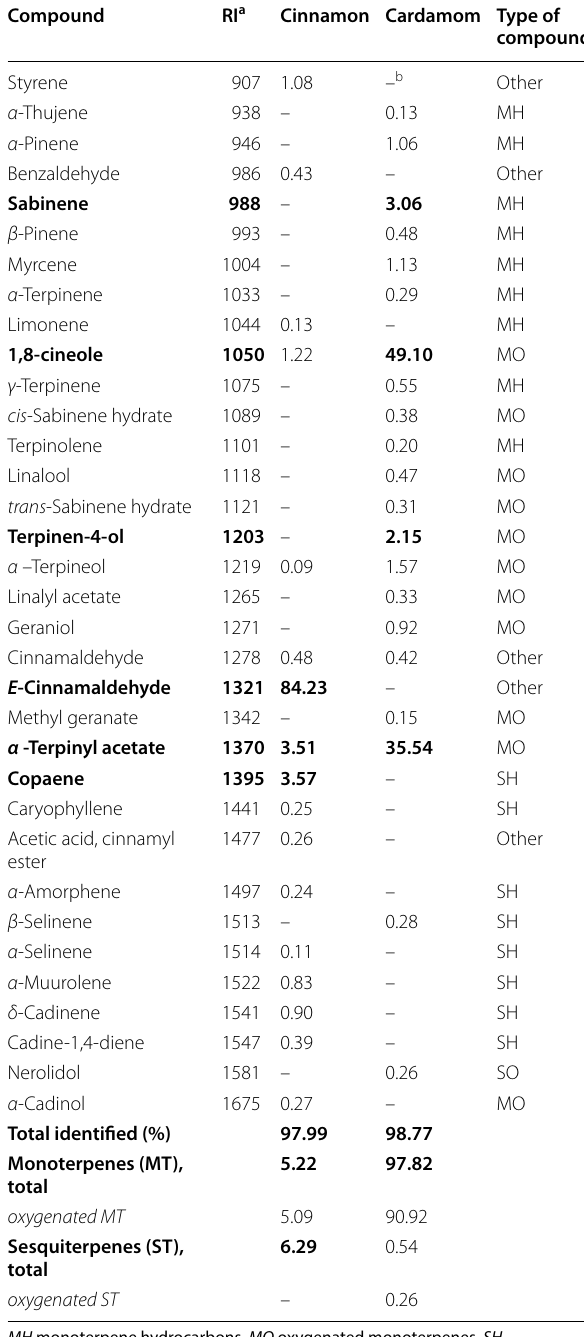
Table 4 Chemical composition (%) of cinnamon and cardamom essential